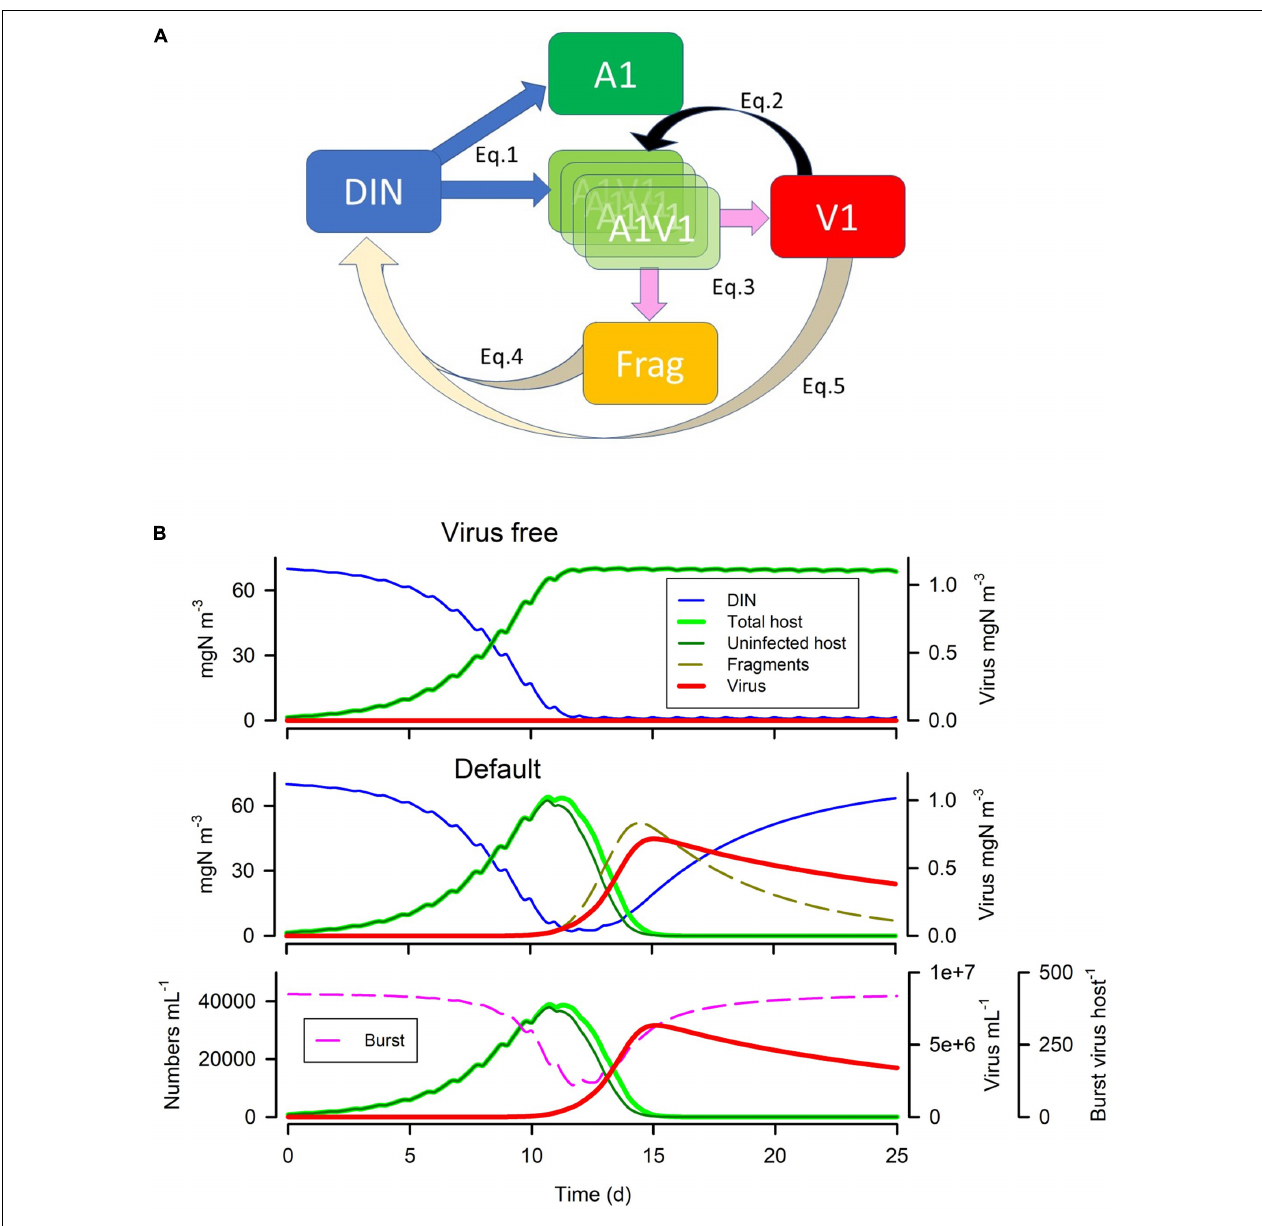
FIGURE 1 | Model schematic and example (default) simulations. Panel (A) shows the connectivity between the state variables for inorganic nutrient (dissolved inorganic N; DIN), the phytoplankton host (A1), virus (V1), infected host (A1V1) and fragments of burst host (Frag). Note that A1V1 is described by an arrayed state variable, such that infection introduces a value into the lowest array member, and at each timestep the values are moved up through the array until they either reach the top, or the latent period is attained. The infected host then bursts releasing fragments (Frag) and new V1. See equations and adjoining text in Methods for more information. Panel (B) shows the default simulation output, showing in the upper plot the dynamics with no infection, and in the lower two panels the dynamics with infection. The lowest plot shows numeric abundance with burst size; note that burst size decreases slightly with declining host nutrient status (which tracks declining DIN). The proportion of host (A1) that is infected is seen by the difference between “total” and “uninfected”. See also Table 4